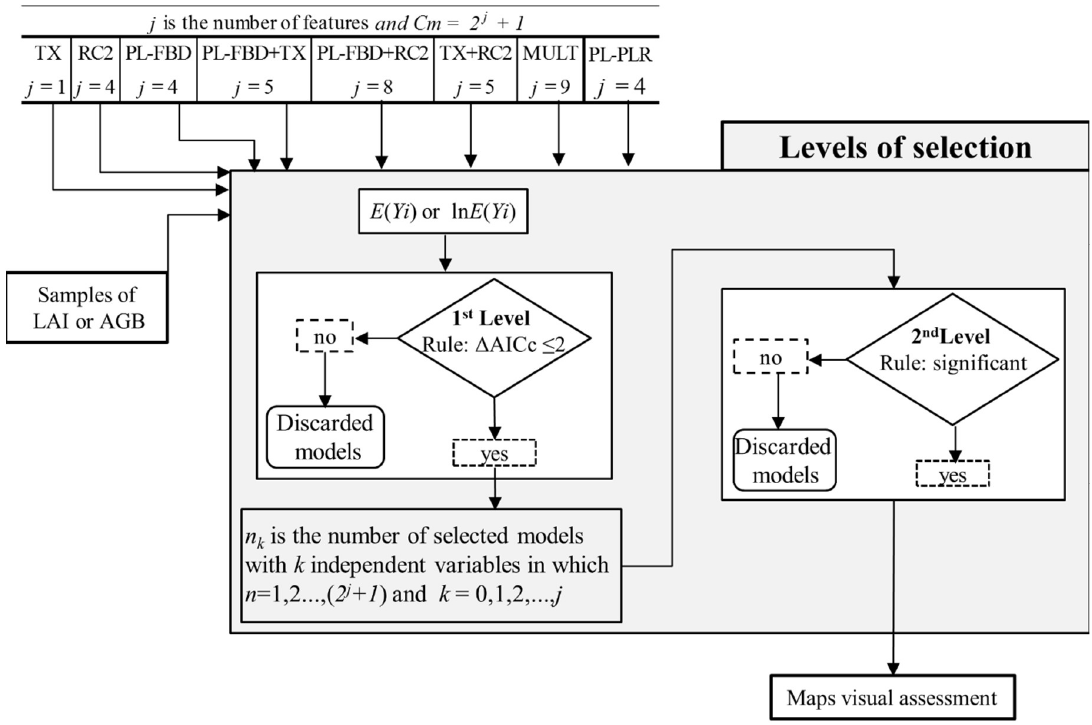
Figure 4. Flowchart: Models selection process for SAR Single/dual-pol and Multifrequency data type.